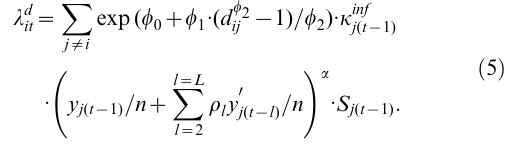
Table 1. Estimated parameters in the expected abundance m corresponding relative BIC values for selected